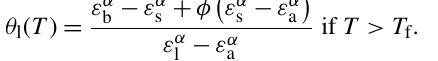
Figure C10. Borehole, Bayelva, drilled in March 2009 (total depth of 9.3m) and instrumented in August 2009–present, (78.92082 ◦ N, 11.83421 ◦ E). (a) Borehole site with PVC casing outside the borehole and wooden ventilation shield removed. Setup (b) with a Geoprecision temperature chain with probes at depths of 0.5 above ground surface and 0, 0.5, 1.0, 1.5, 2.5, 3.5, 5.5, 7.5 and 9m below ground surface was used for May 2009–September 2015 and May